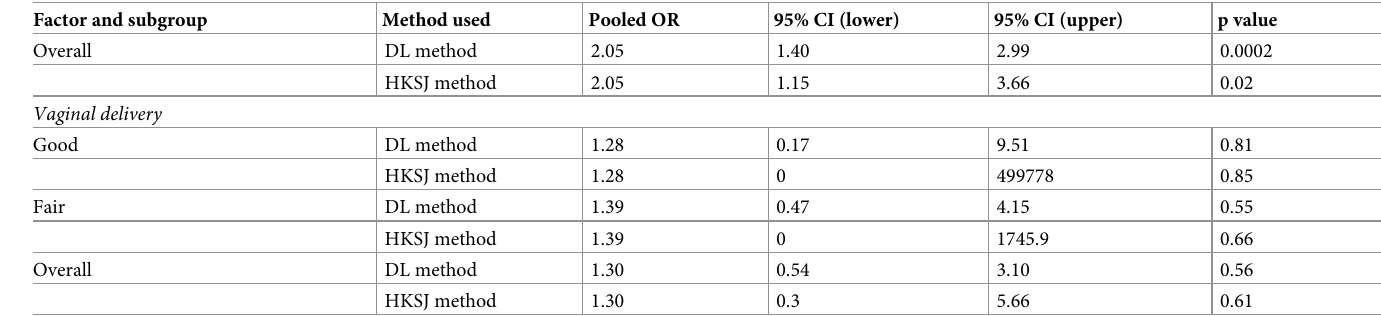
PLOS ONE | https://doi.org/10.1371/journal.pone.0215683 April 25,